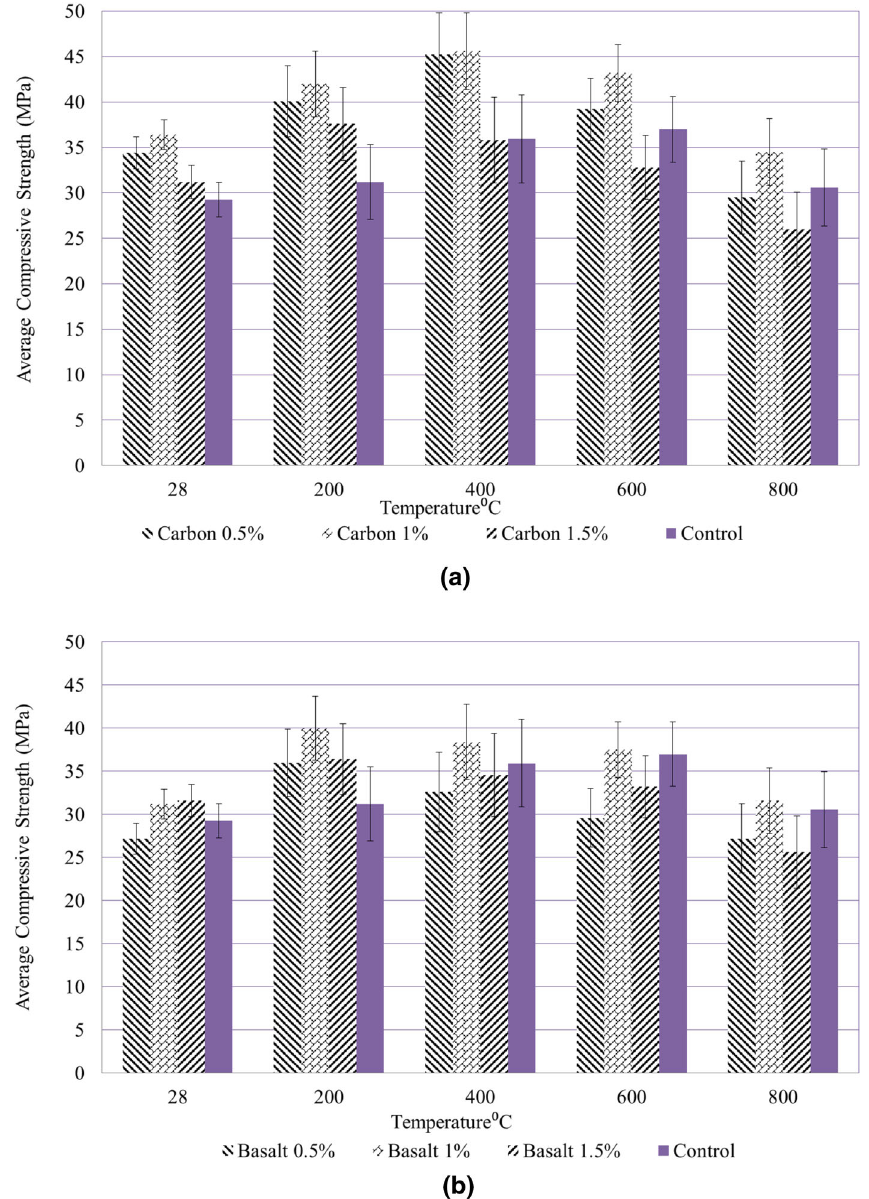
Fig. 6 Compressive strength of pure geopolymer and carbon and basalt fibre reinforced geopolymer at ambient and at various elevated temperatures. a Carbon fibre geopolymer composites and b Basalt fibre geopolymer